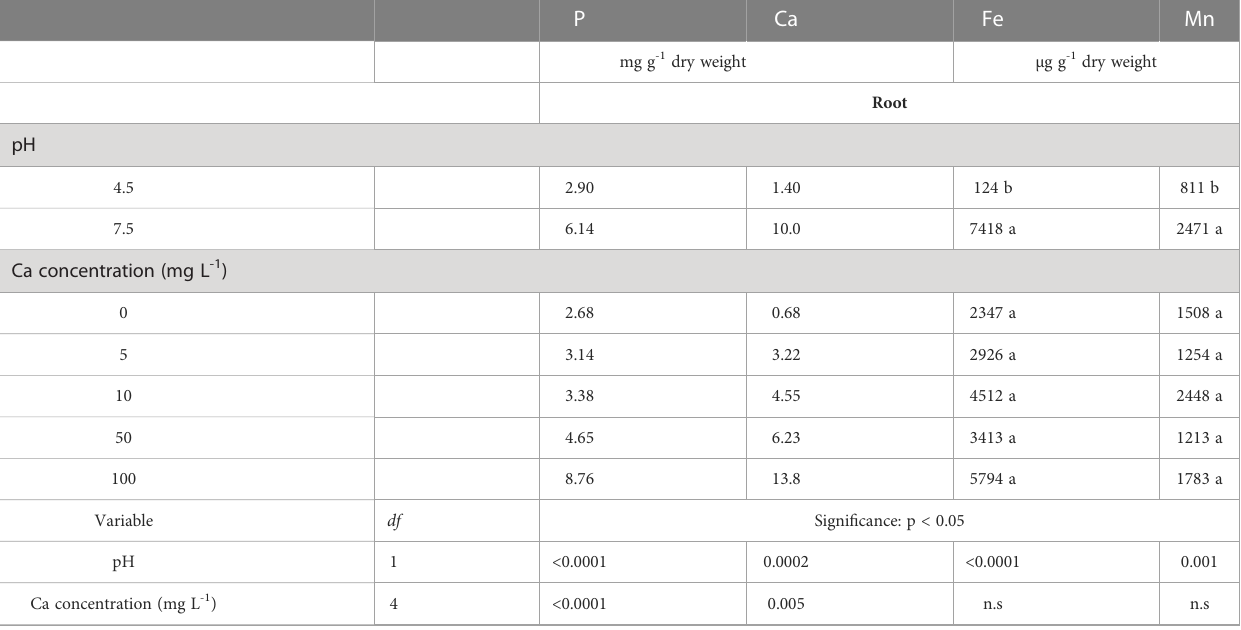
TABLE 2 Effects of pH (4.5 and 7.5) and Ca concentration (0, 5, 10, 50 and 100 mg L -1 ) on the concentrations of selected elements in the root, shoot and leaf of Southern highbush blueberry ( Vaccinium corymbosum , cv. Windsor) plants after 12 weeks of growth in nutrient